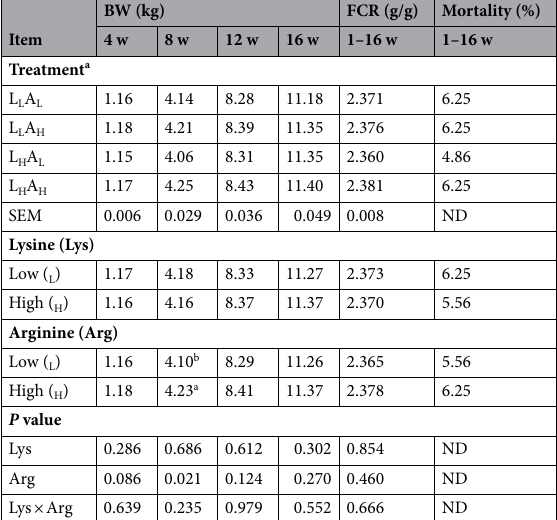
Table 1. Body weights (BW) and the feed conversion ratio (FCR) in turkeys fed diets with different Arg:Lys ratios. a L